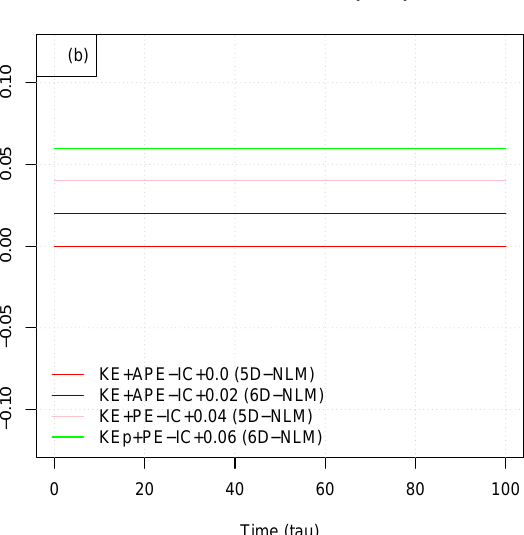
Figure 1. Time evolution of energy conservation laws from the 5D- NLM and 6D-NLM. (KE + PE) and (KE + APE) are displayed for the 5D-NLM, while (KE p + PE) and (KE + APE) are shown for the 6D-NLM. (a) and (b) are for r = 25 and r = 45, respectively. All fields are normalized using the constant C o and each of the above lines is shifted to the summation of the cor- responding initial value and a constant value (e.g., 0.06 in the green